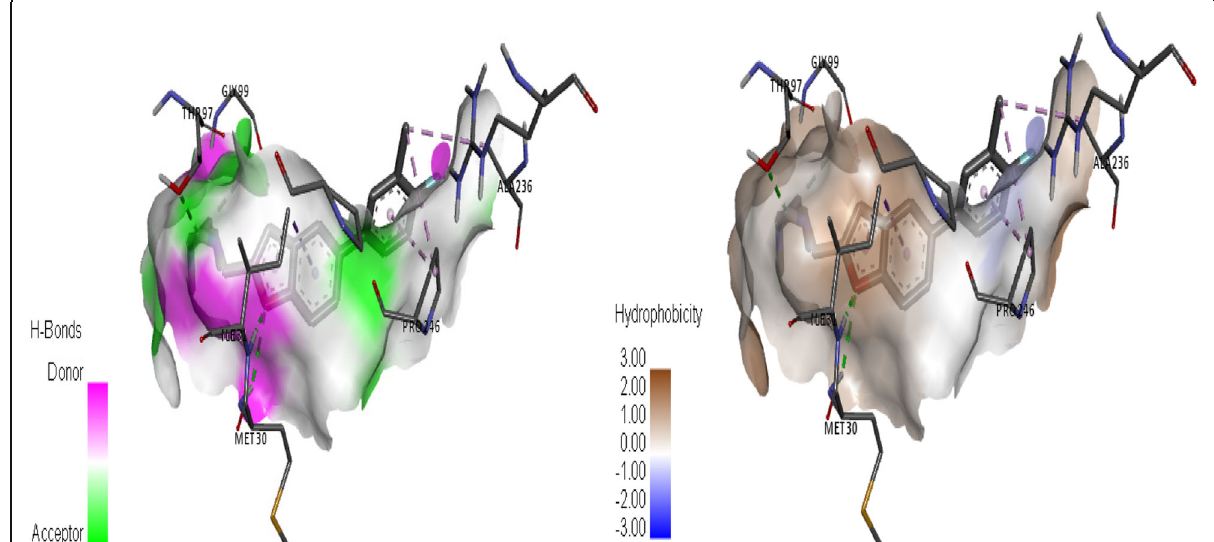
Fig. 5 Hydrogen bonds and hydrophobicity surfaces of 22- pf LDH